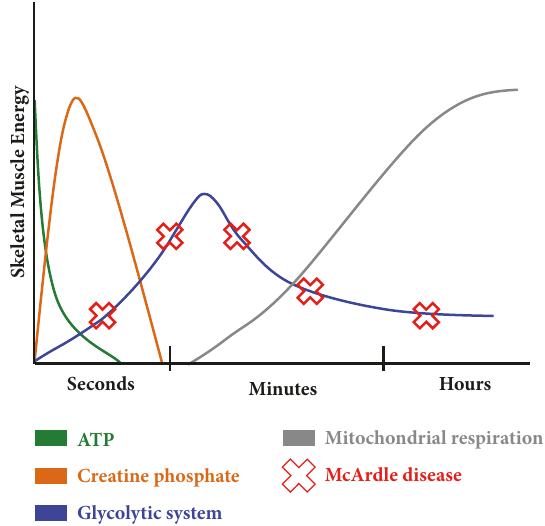
Figure 1: Schematic representation of the main energy sources for skeletal muscles during exercise. Red crosses represent the affected glycolytic system (glycogen) in McArdle